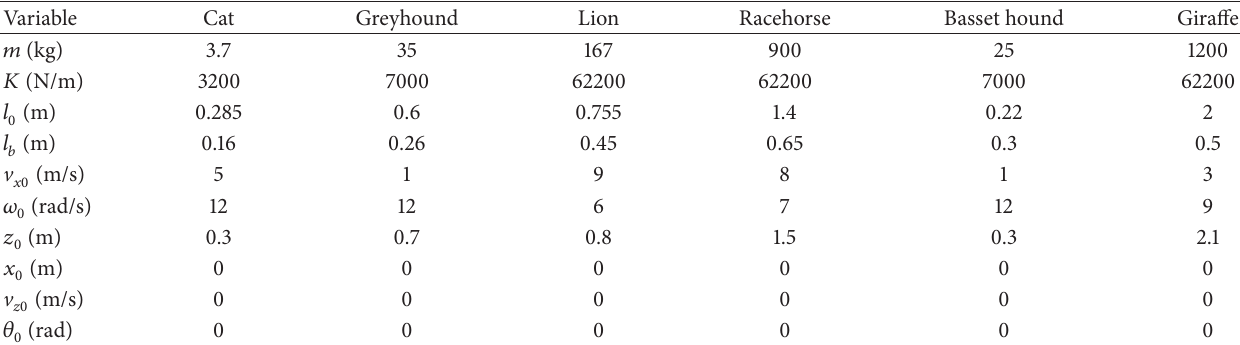
Table 2: Parameters of animals and the initial values of simulation [23–28].